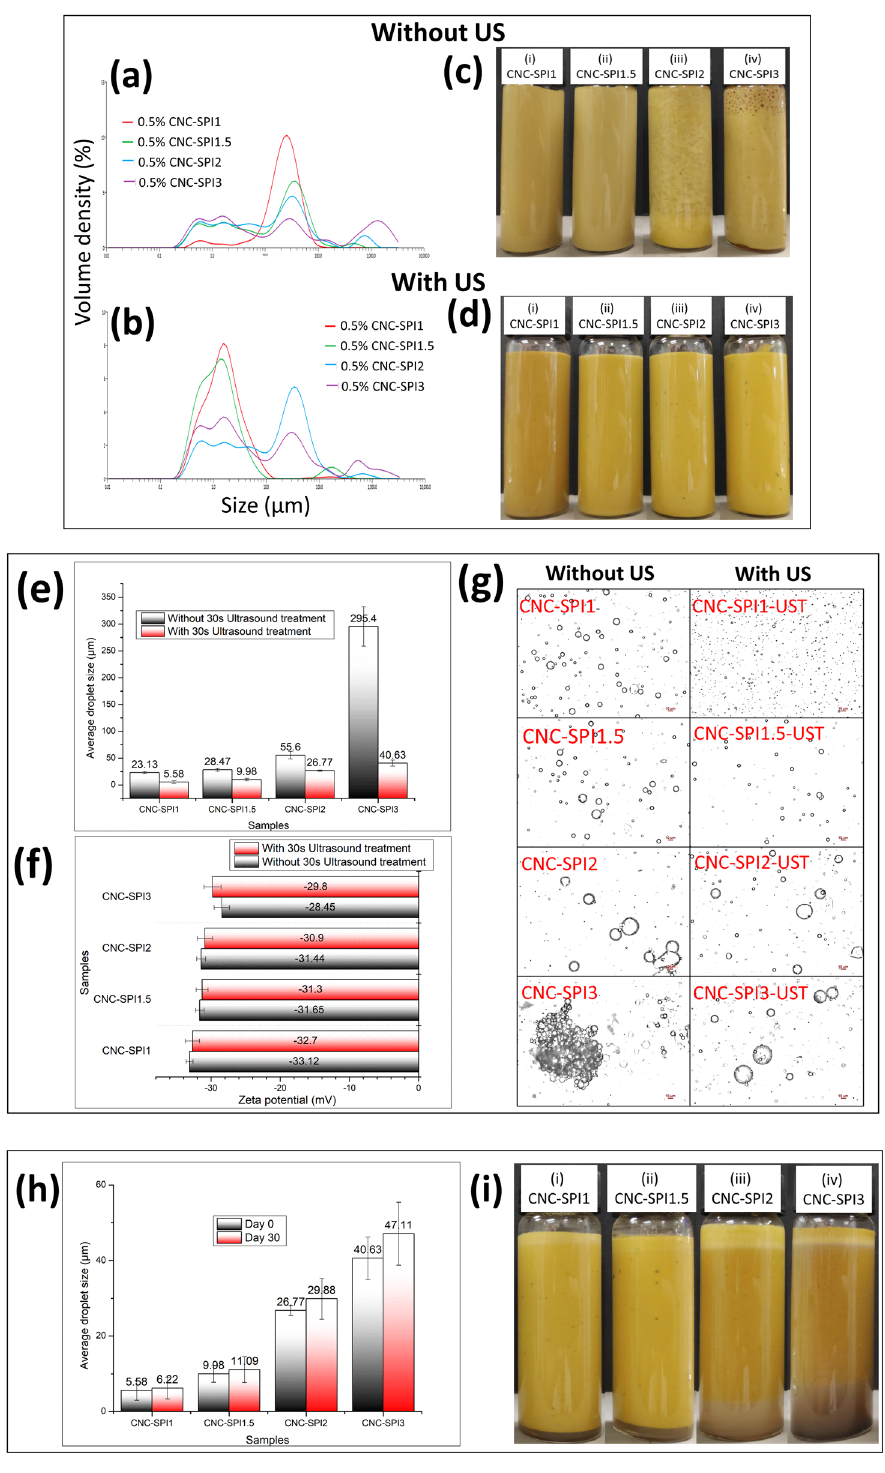
Figure 5: Droplet size distribution of the Pickering emulsions formed ( a ) without ultrasound treatment, ( b ) with ultrasound treatment before emulsi fi cation and visual observations, ( c ) without ultrasound treatment, ( d ) with ultrasound treatment before emulsi fi cation, ( e ) average droplet size, d 4,3 values, ( f ) zeta potential, ( g ) optical micrographs of the Pickering emulsion stabilized by CNC – SPI nanoconjugates, ( h ) average droplet size, d 4,3 values, and ( i ) visual observation of emulsions at days 0 and 30. The error bars represent the standard error of